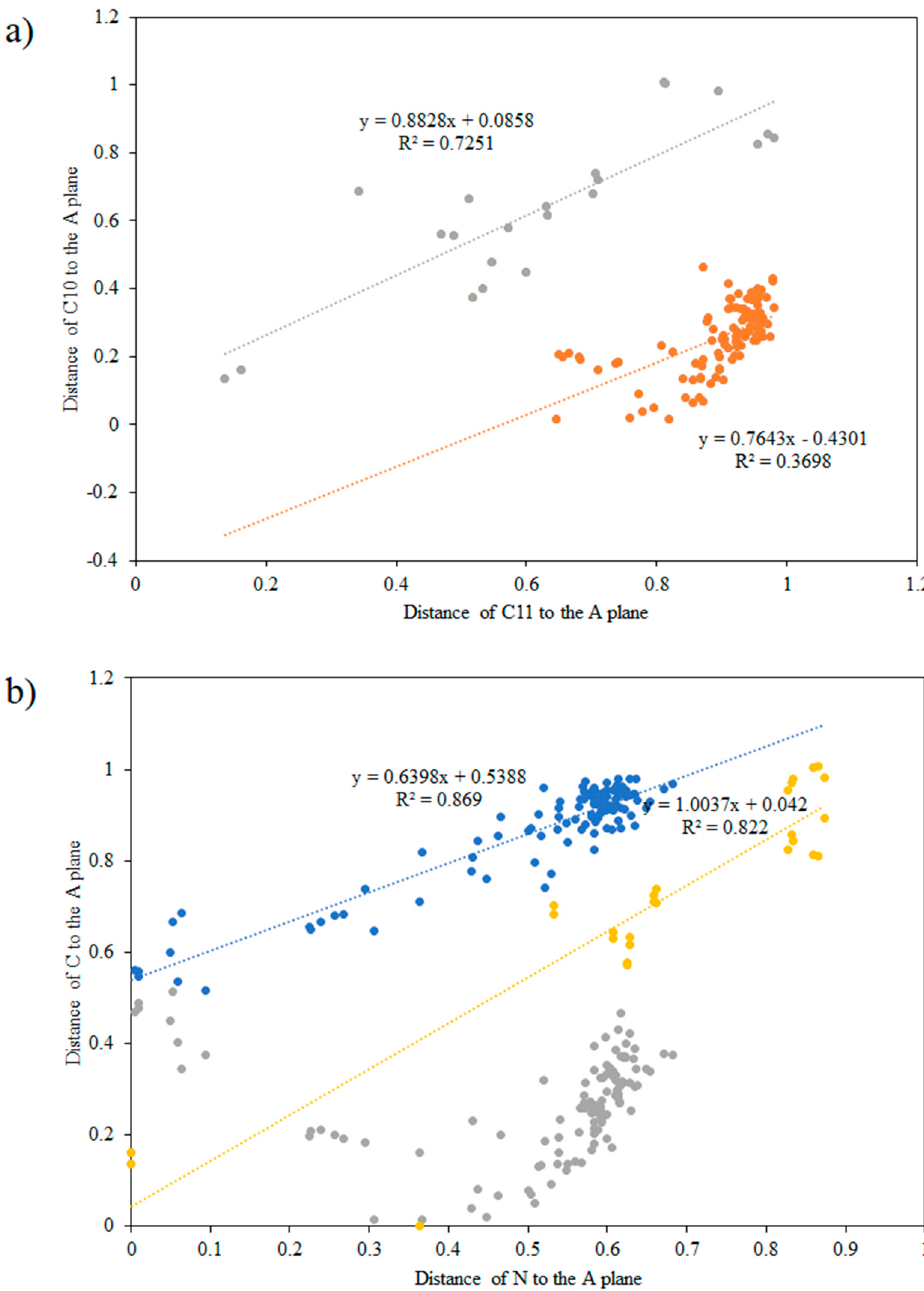
Figure 2. Correlation for 10,11-dihydro-5 H -dibenzo[b,f][7]azepine. ( a ) Correlation of C10 and C11 distance to the A plane: gray—azepines with substituents in C10 and C11 positions, orange—azepines without substituents in C10 and C11 positions. ( b ) The distance of C10 and C11 to N5 of the A plane: blue and gray—azepines without substituents in C10 and C11 positions, yellow—azepines with substituents in C10 and C11 positions for 10,11-dihydro-5 H